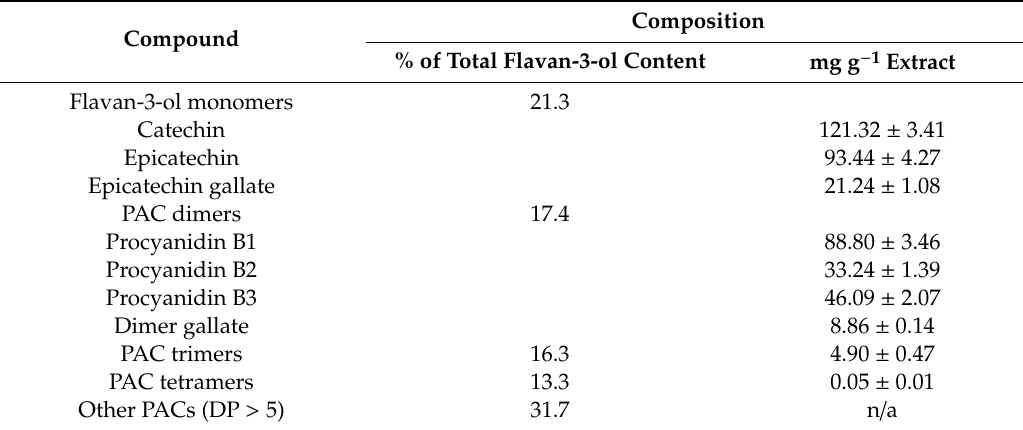
Table 3. Main compounds of the PAC-rich grape-seed extracts (GSPE) used in the in vivo studies on cafeteria (CAF) diet-induced intestinal